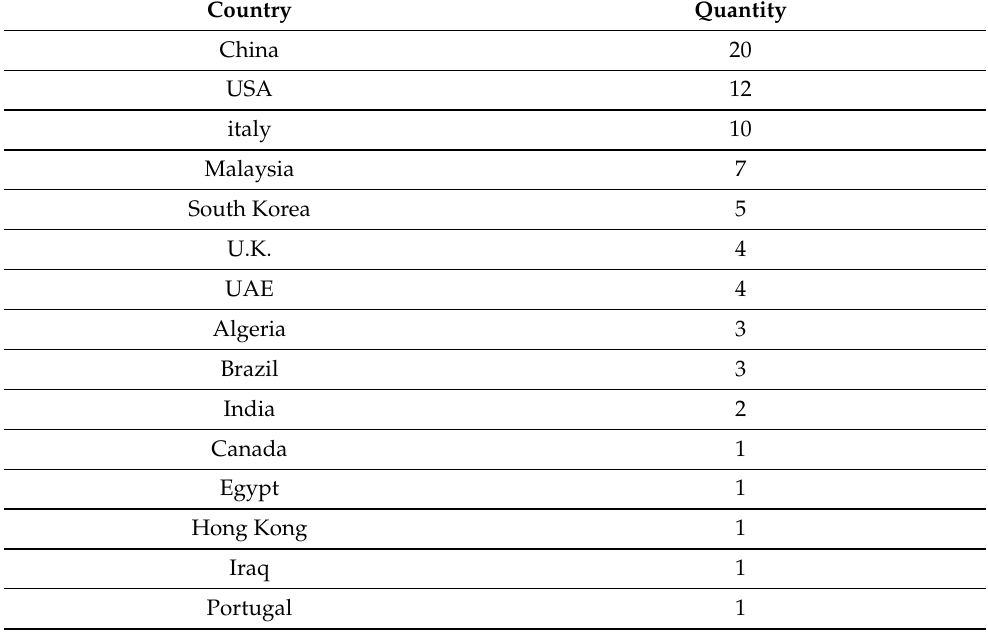
Table 4. Country